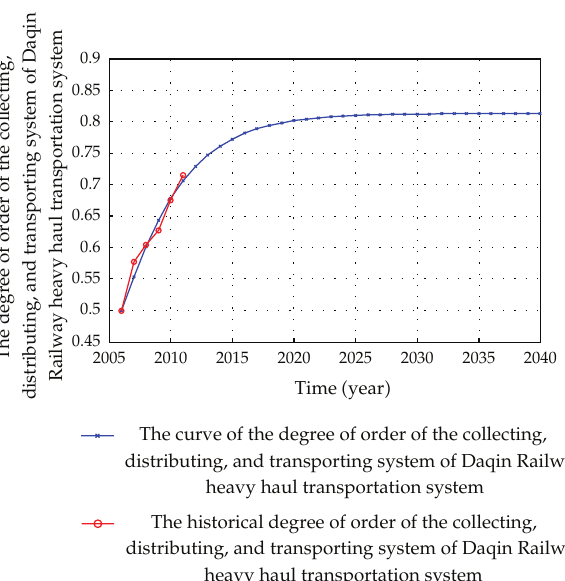
Figure 5: The synergy evolution curve of the collecting, distributing, and transporting system of Daqin Railway heavy haul transportation.